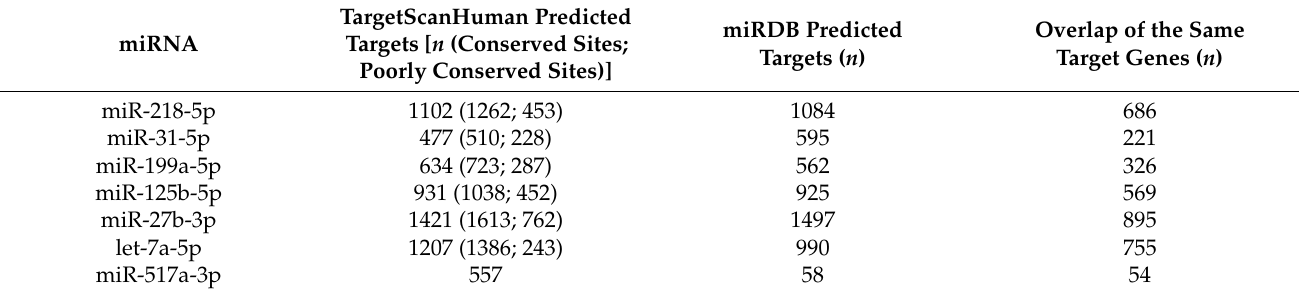
Table 1. List of predicted target genes of differentially expressed